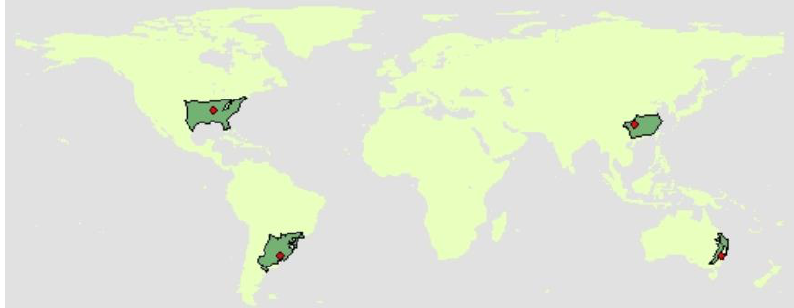
Figure 1. Main humid subtropical regions, according to the Köppen climate classification [30]: southeast U.S., southeast China, South America, and east Australia. Red diamonds indicate reference locations for climate characteristics.